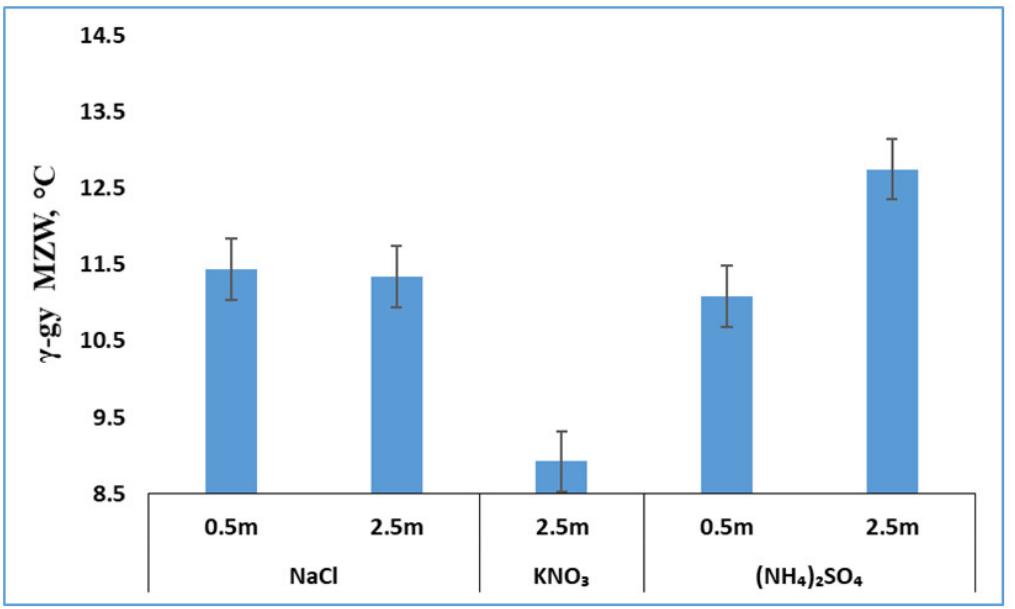
Figure 4. Effect of three salts on the MZWs of γ-glycine nucleation (error bar = ±0.4 °C).